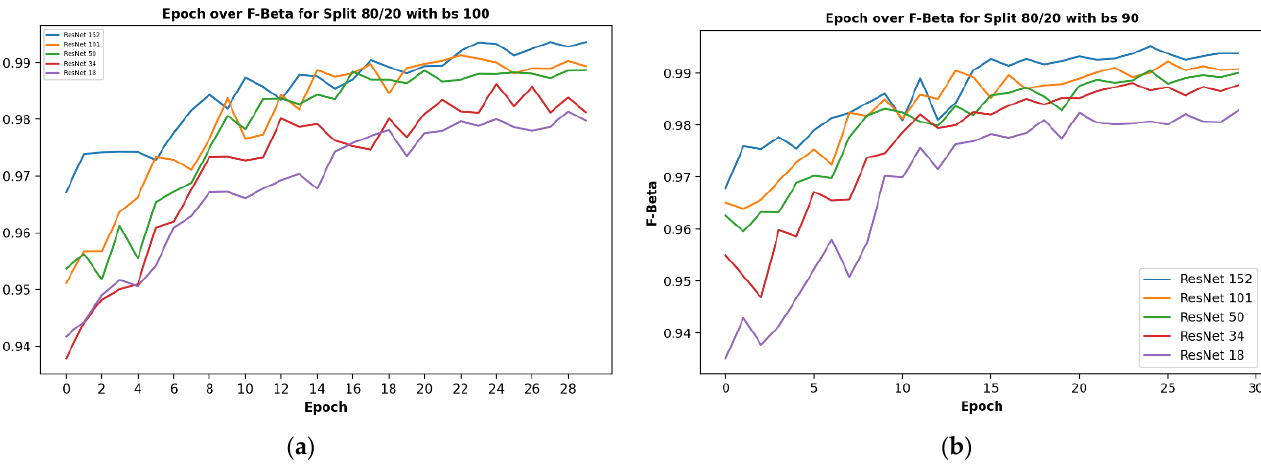
( f ) Figure 8. Showing the results on different train/test split ratios on various models used in our re- search: ( a ) showing epoch over F1 score for ResNet-18; ( b ) showing epoch over F1 score for ResNet- 34; ( c ) showing epoch over F1 score for ResNet-50; ( d ) showing epoch over F1 score for ResNet-101;